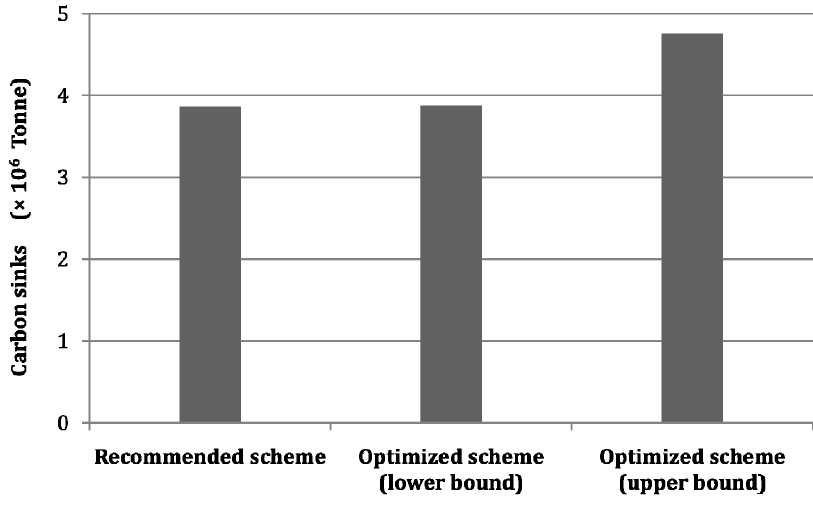
Figure 2. Total carbon sink capacities of the CDM project’s original recommended scheme and the optimal solutions over a 25-year